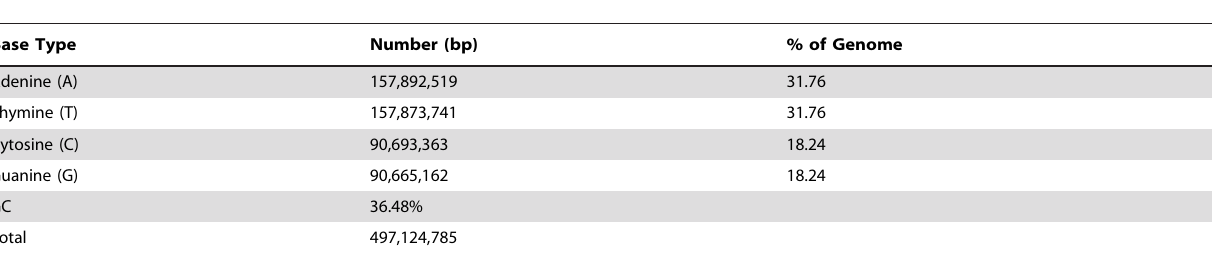
Table 6. The base content in adzuki bean weevil genome.